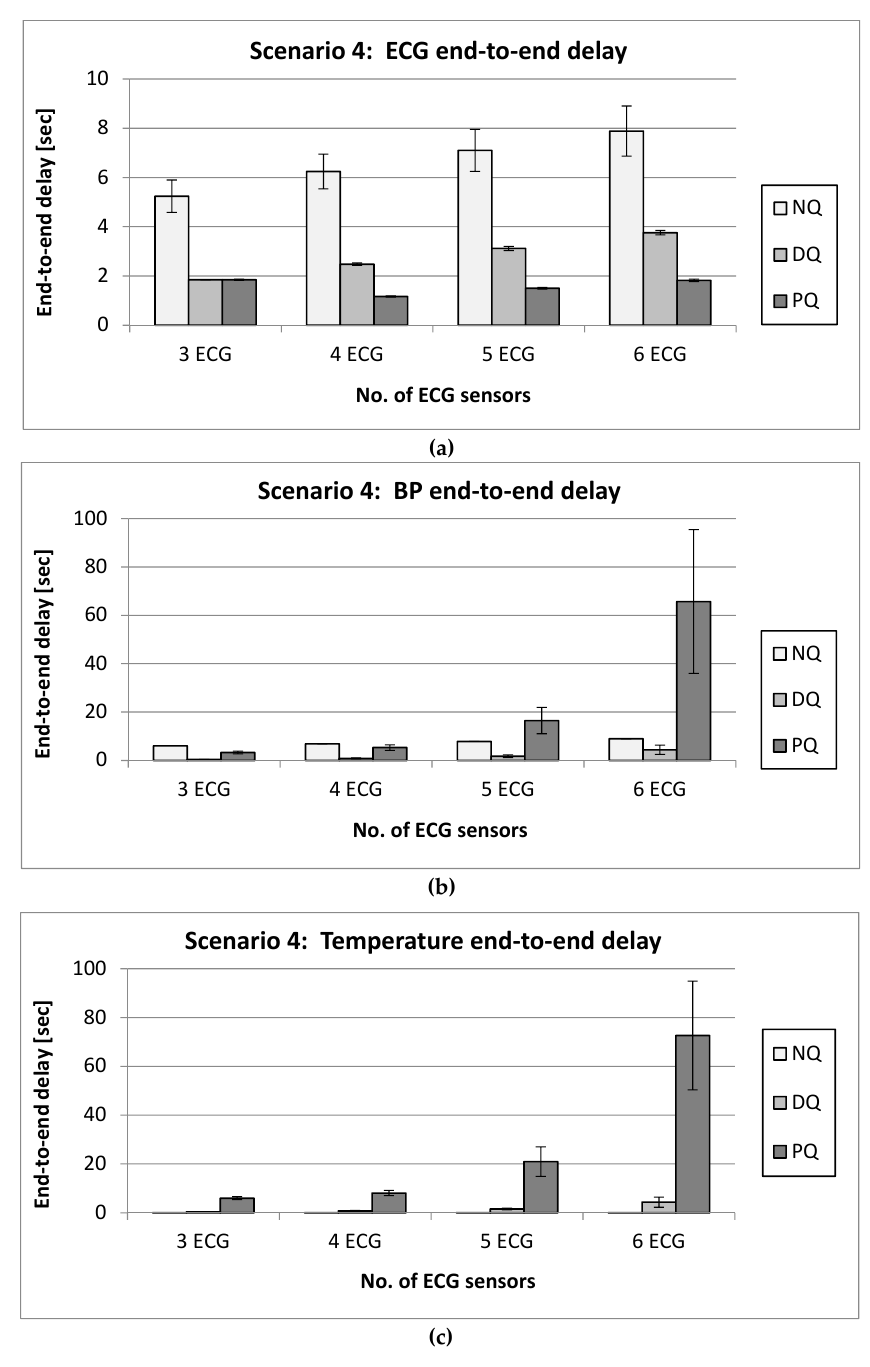
Figure 12. Average end-to-end packet delay results comparison for various data traffic types .